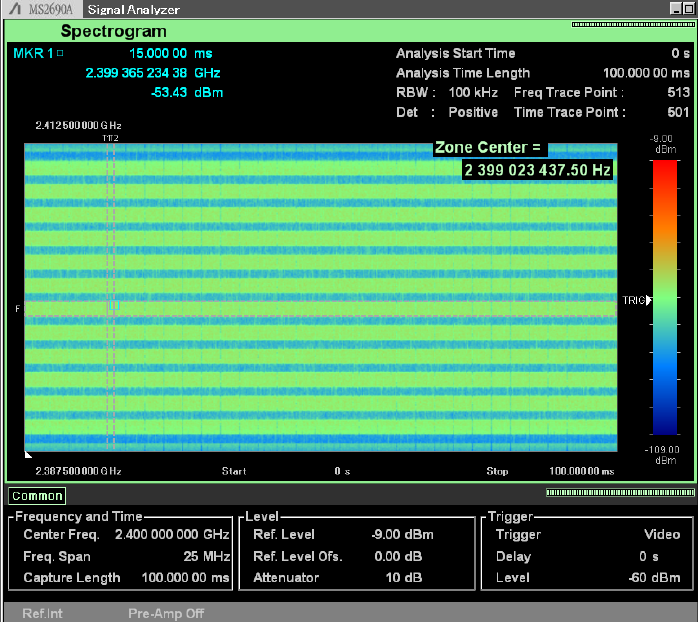
Figure 18. Spectrogram of 12 vPHYs concurrently transmitting at a center frequency of 2.4